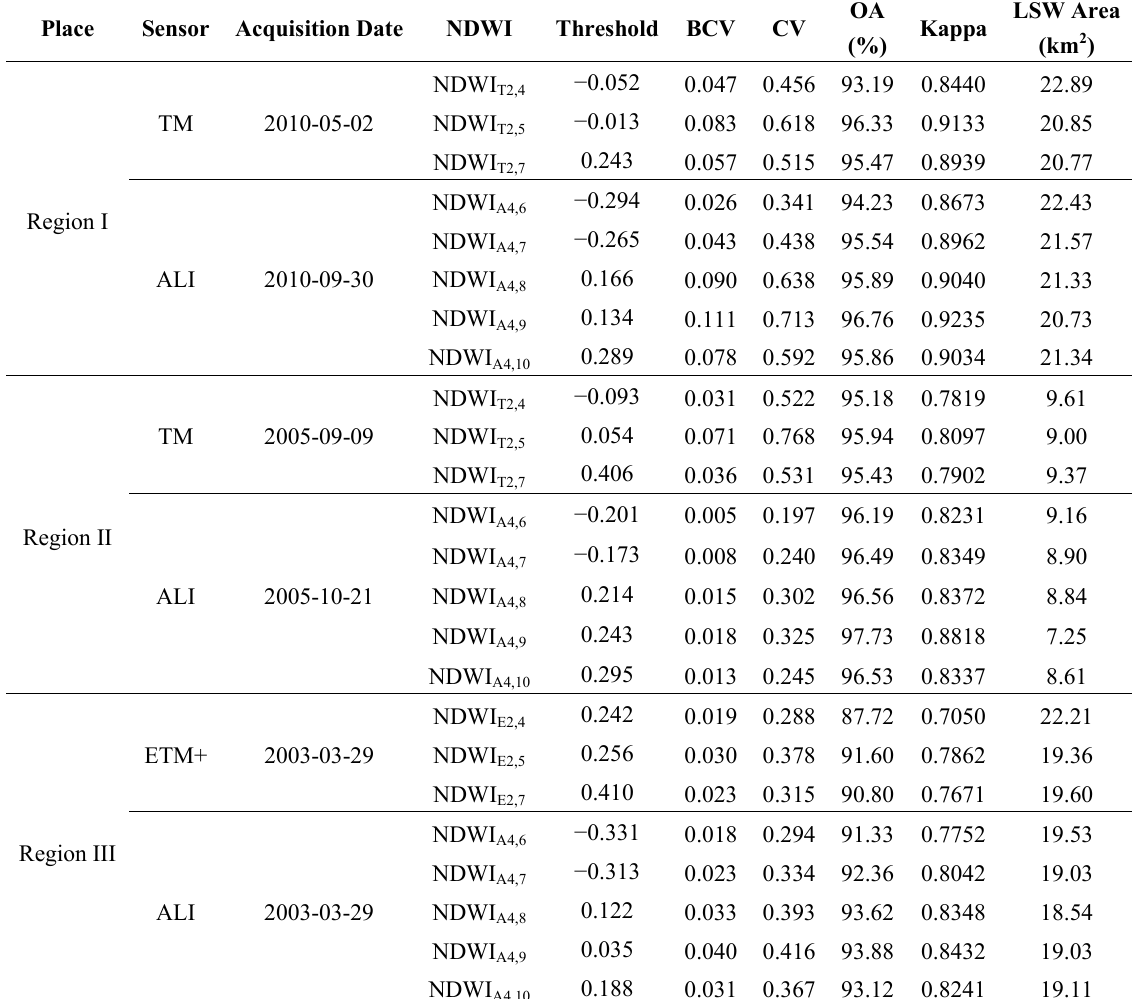
Table 3. NDWI forms, statistical results, associated sensors and bands of the three regions.